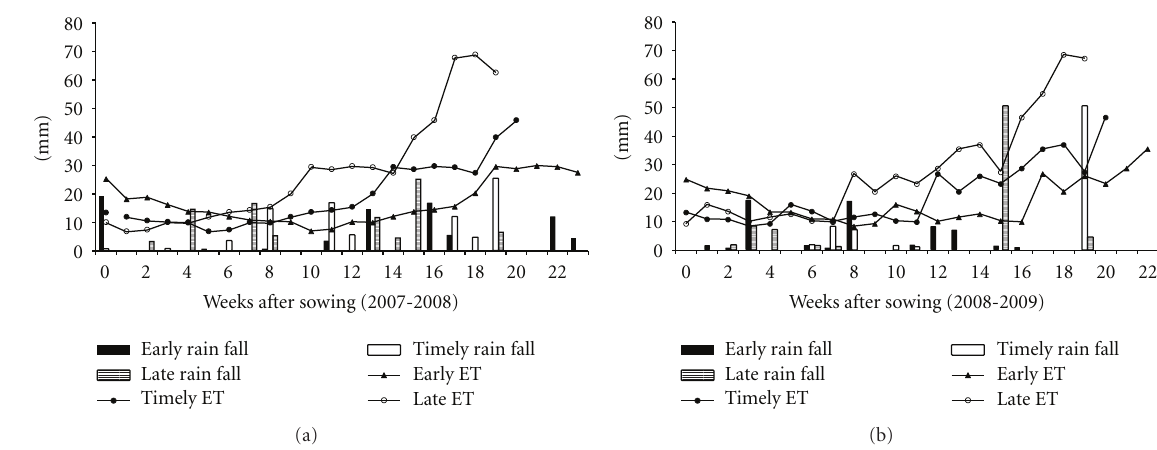
Figure 1: Patterns of total rain fall and evapotranspiration during the wheat growing season for the year 2007-2008 (year I) and 2008-2009 (year II). ET,